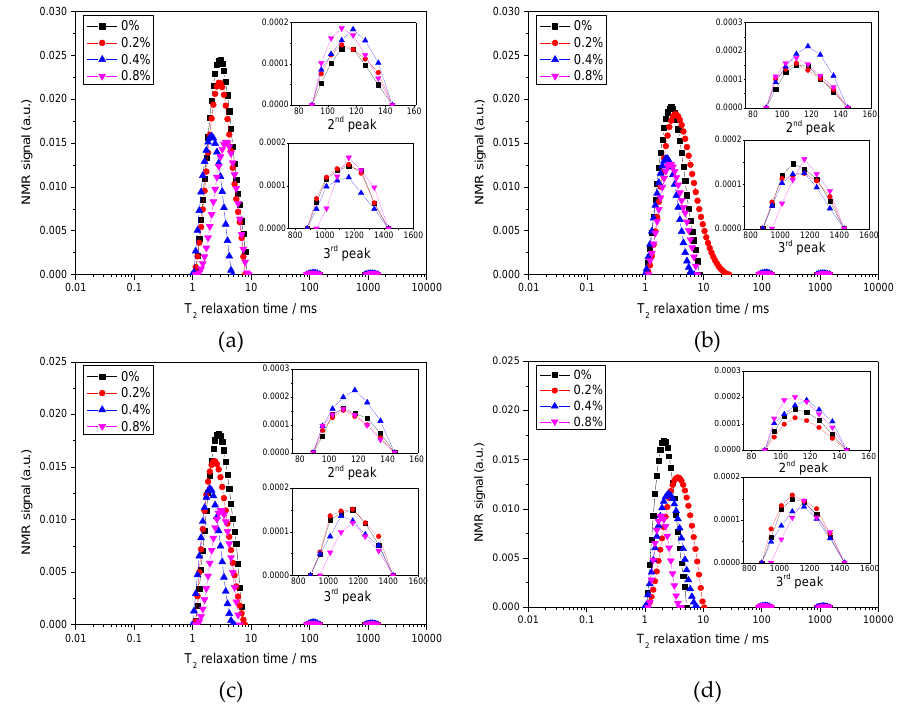
Figure 7. The short-duration T 2 relaxation time of CPB mixture with different polynaphtalene sulfonate dosages when the hydration time is: ( a ) 10 min, ( b ) 1 h, ( c ) 2 h, and ( d ) 8 h.